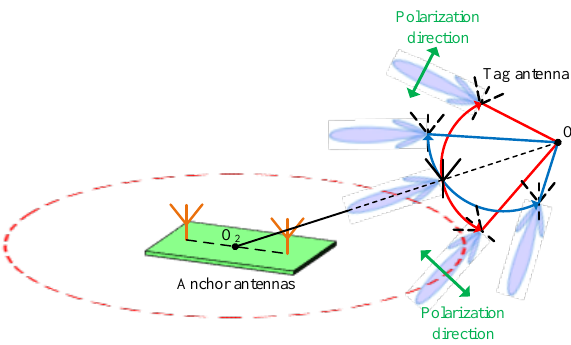
Figure 2. Scenario 1: Tag antenna deflects from its boresight (O 1 O 2 ).